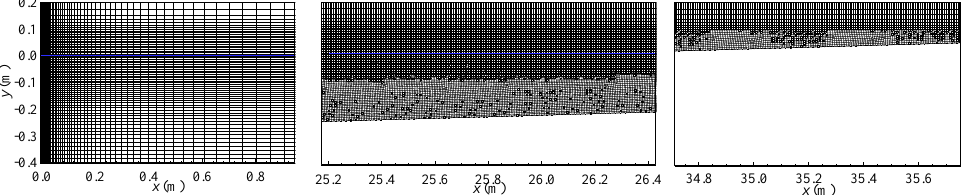
Figure 8. Details of the mesh for the spilling case (Ting and Kirby [6]) near the wave-maker, along the slope and at the end of the domain. The blue line indicates the SWL.